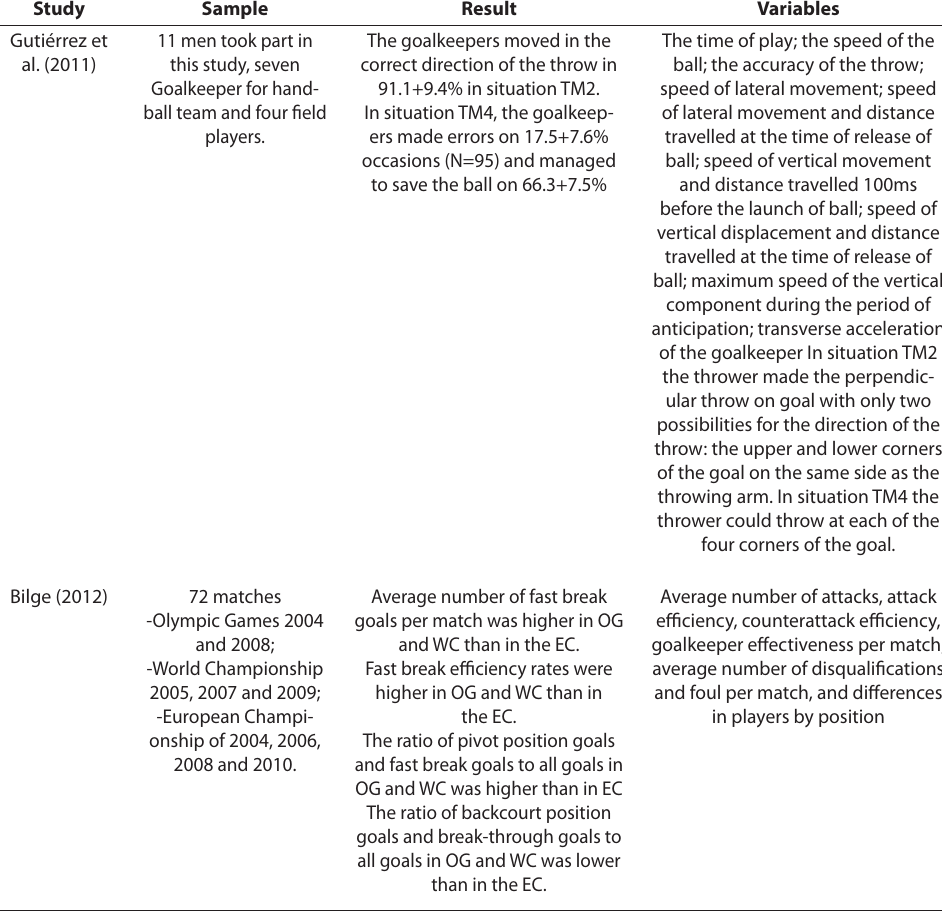
TABLE 2 Empirical studies predominantly with comparative analysis based on TTOs Study Sample